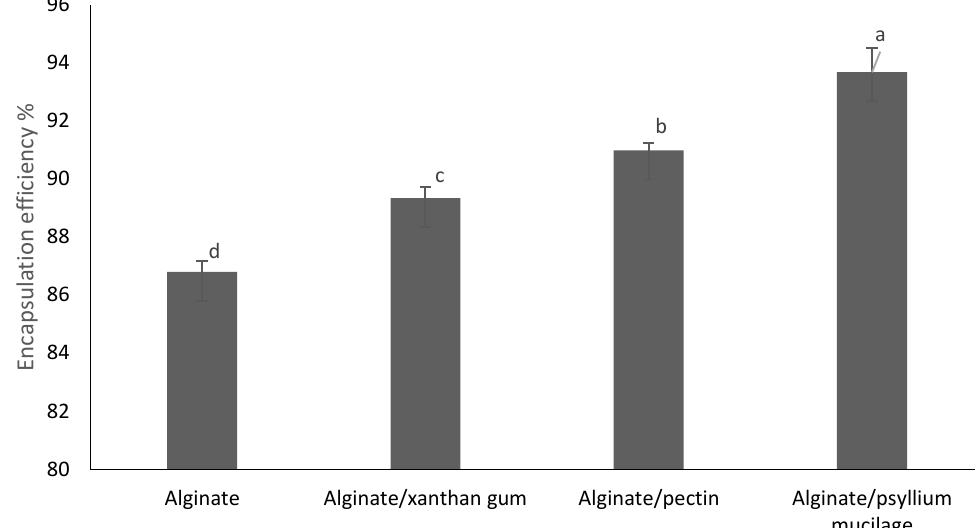
Figure 2. Effect of different polymers on the encapsulation efficiency of alginate-based beads. Er- ror bars show the standard deviation value. Different letters over error bars indicate statistically significant results.